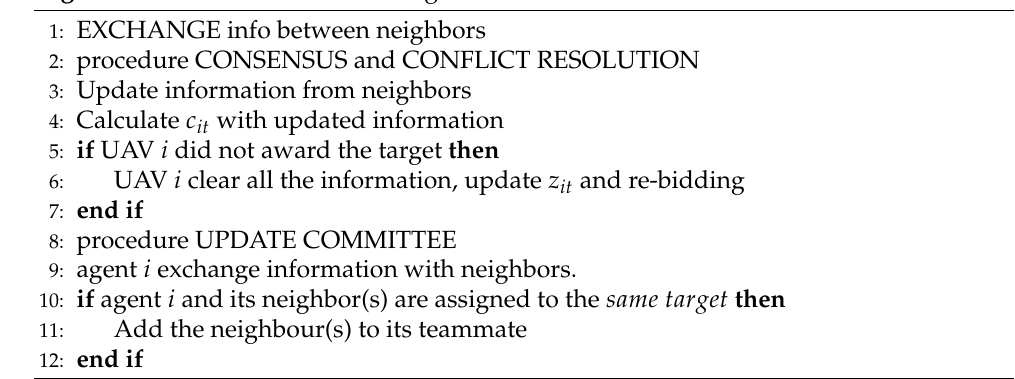
Algorithm 2 C-CBAA Phase 2 for agent i at iteration τ